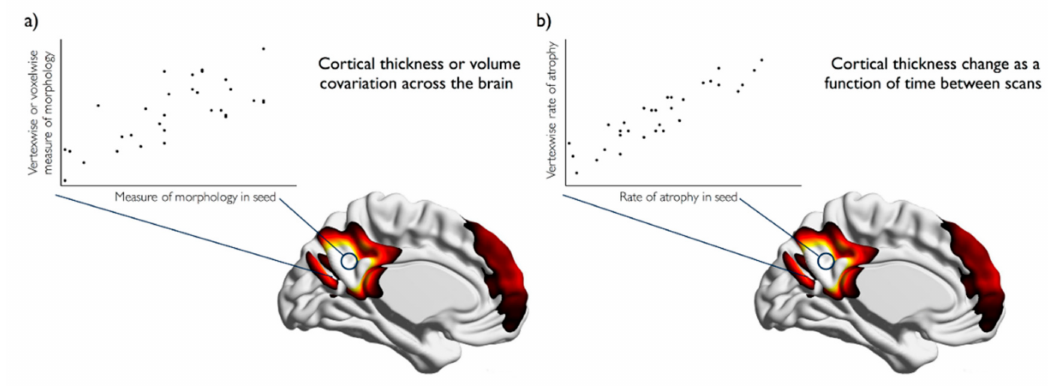
Figure 1. Hypothetical, illustrative examples of ( a ) structural covariance and ( b ) atrophic covariance of the default mode network. ( a ) In structural covariance, volume or cortical thickness in a posterior cingulate seed (circle shape) is compared to volume or cortical thickness with the rest of the brain on a voxel- or vertex-wise basis and at a group level; ( b ) In atrophic covariance, the rate of atrophy in the posterior cingulate region (circle shape) is compared with the rate of atrophy in the rest of the brain on a voxel- or vertex-wise basis and at a group level. Colour spectrum represents strength of correlation, with lighter colours reflecting higher correlation